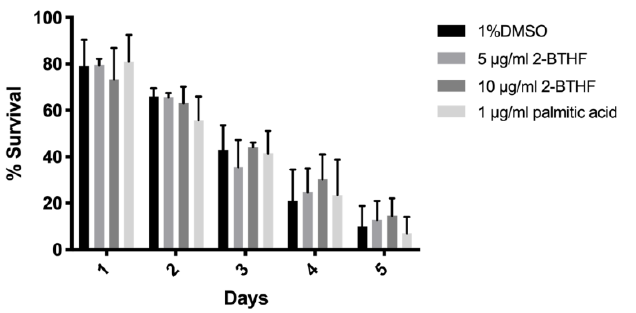
Figure 2. Effects of H. scabra compounds on thermal stress resistance in wildtype N2 worms. Thermal stress result was analyzed by two-way ANOVA following Bonferroni’s method.